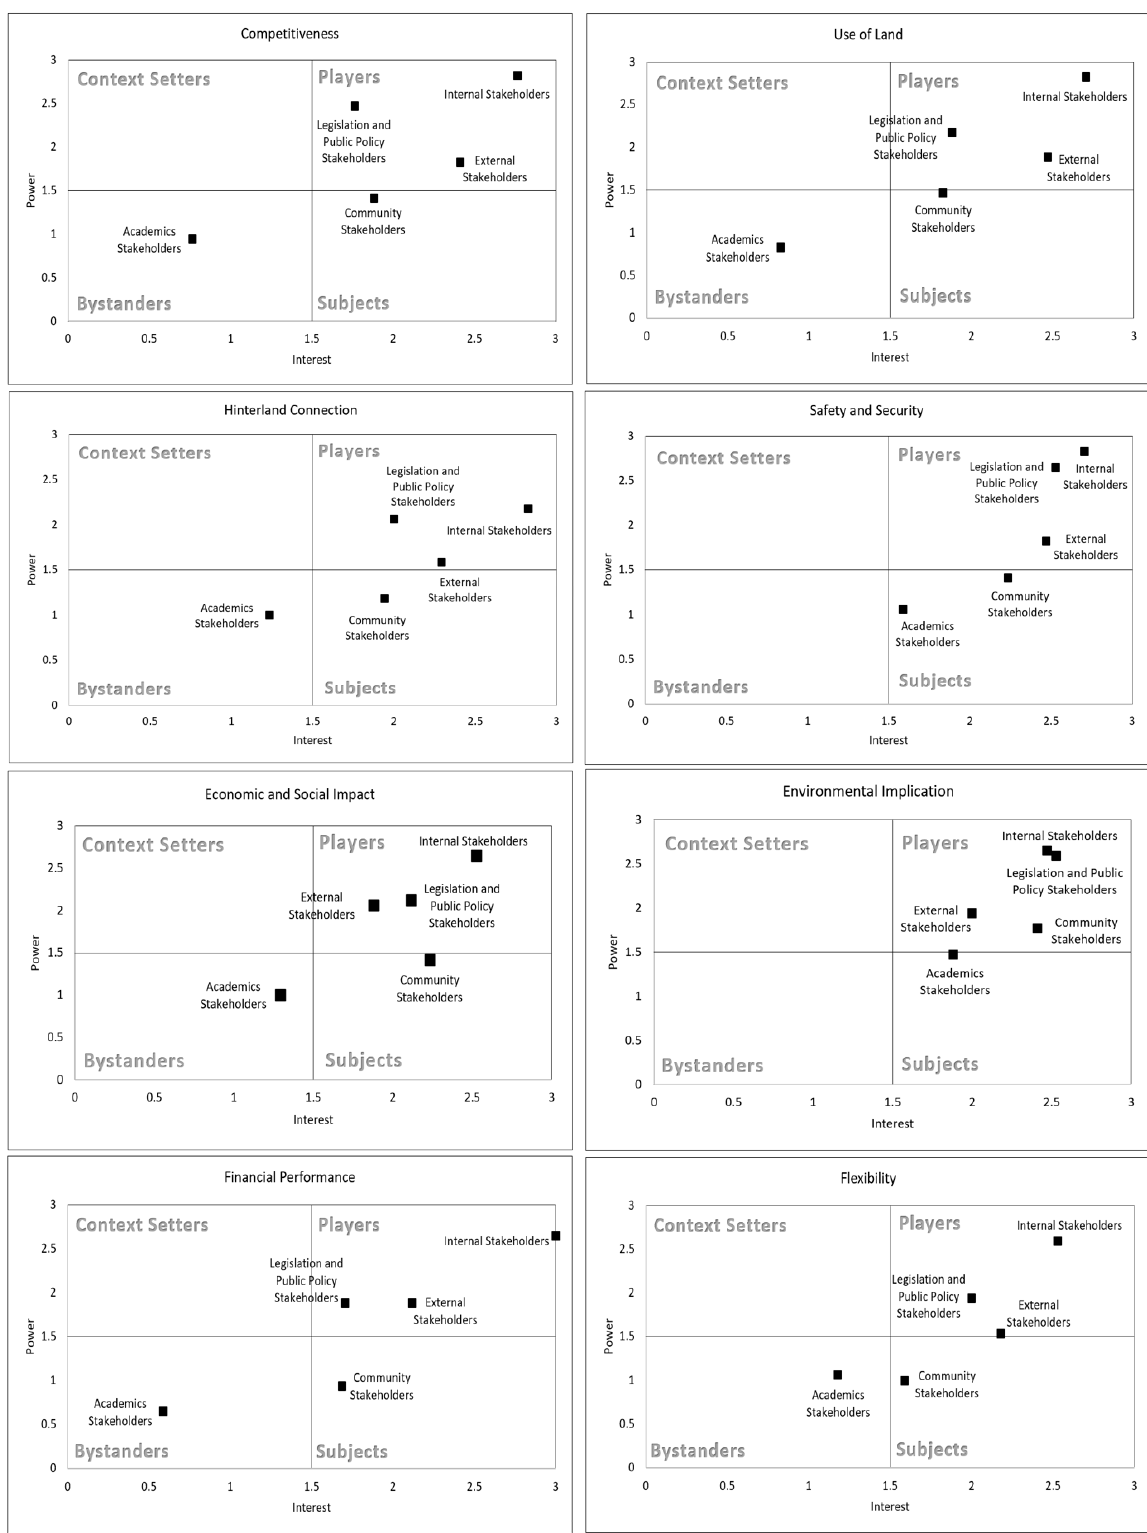
Figure 4. Power-interest matrix for the elements of the port master